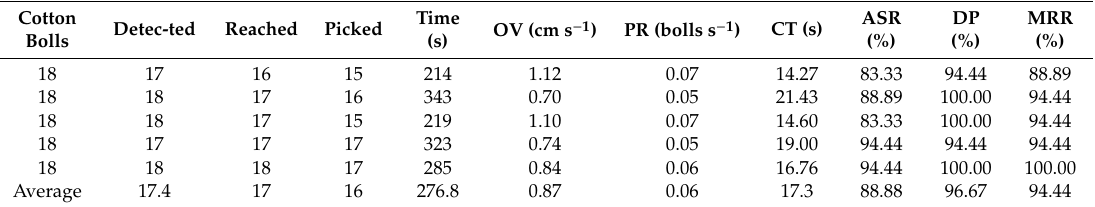
Table 2. The collected data for the experiments done to validate the performance of the system in the simulated